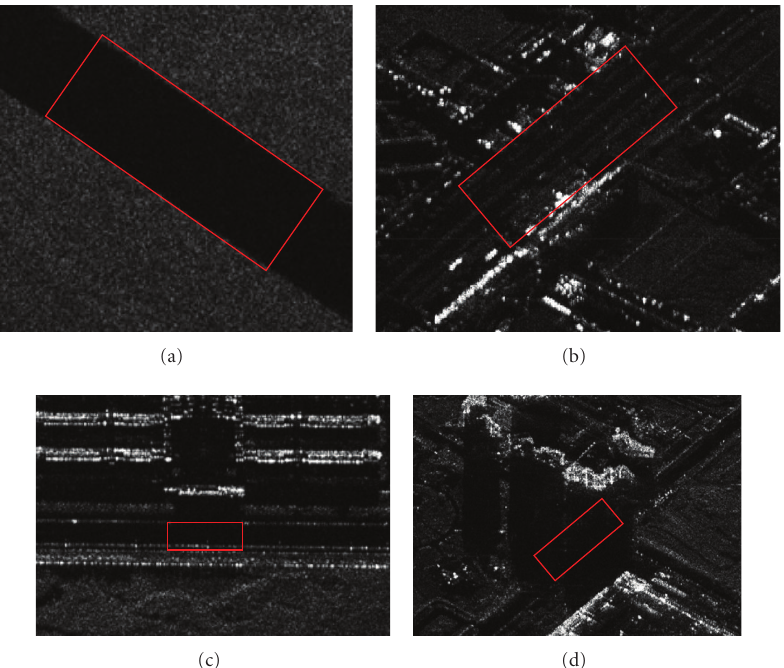
Figure 1: Road edges in high resolution SAR images. (a) Distinct bilateral edges. (b) Blurry road edges. (c) Single edge. (d) No